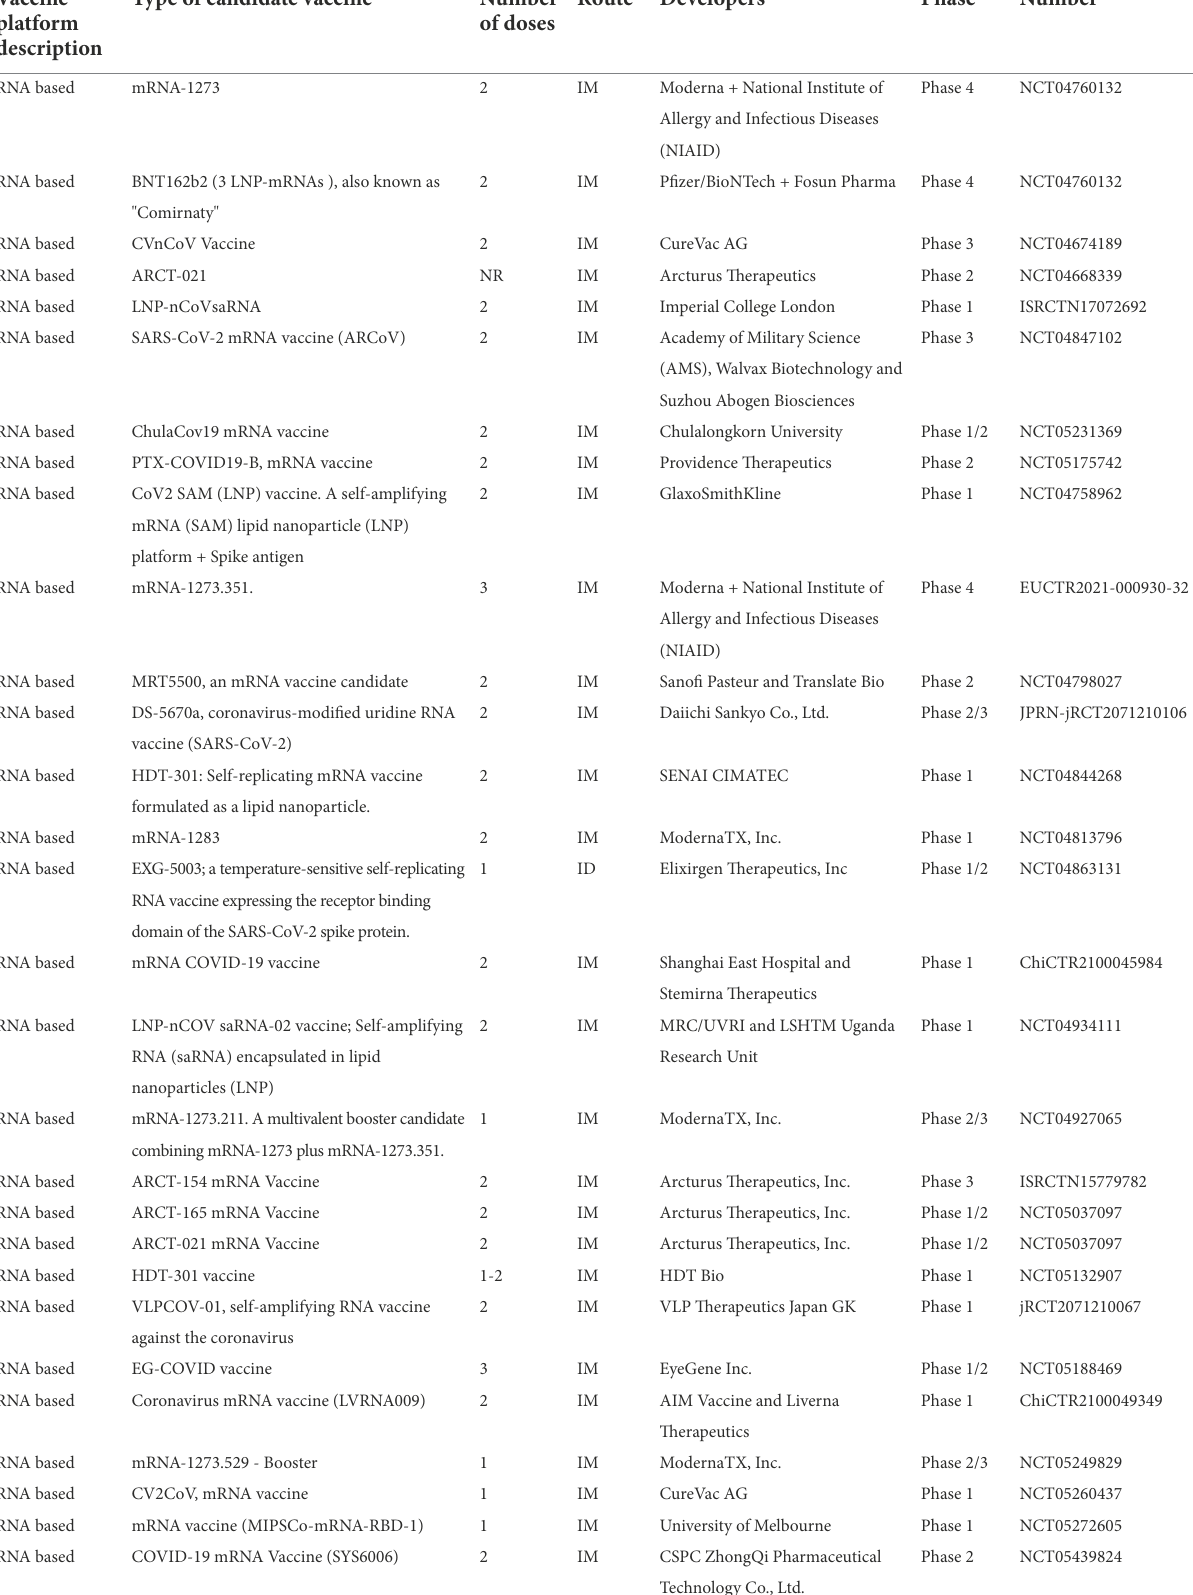
TABLE 1 Clinical application of COVID-19 mRNA vaccine (from https://www.who.int/publications/m/item/draft-landscape-of-covid-19-candidate- vaccines, 30 August 2022). Vaccine platform